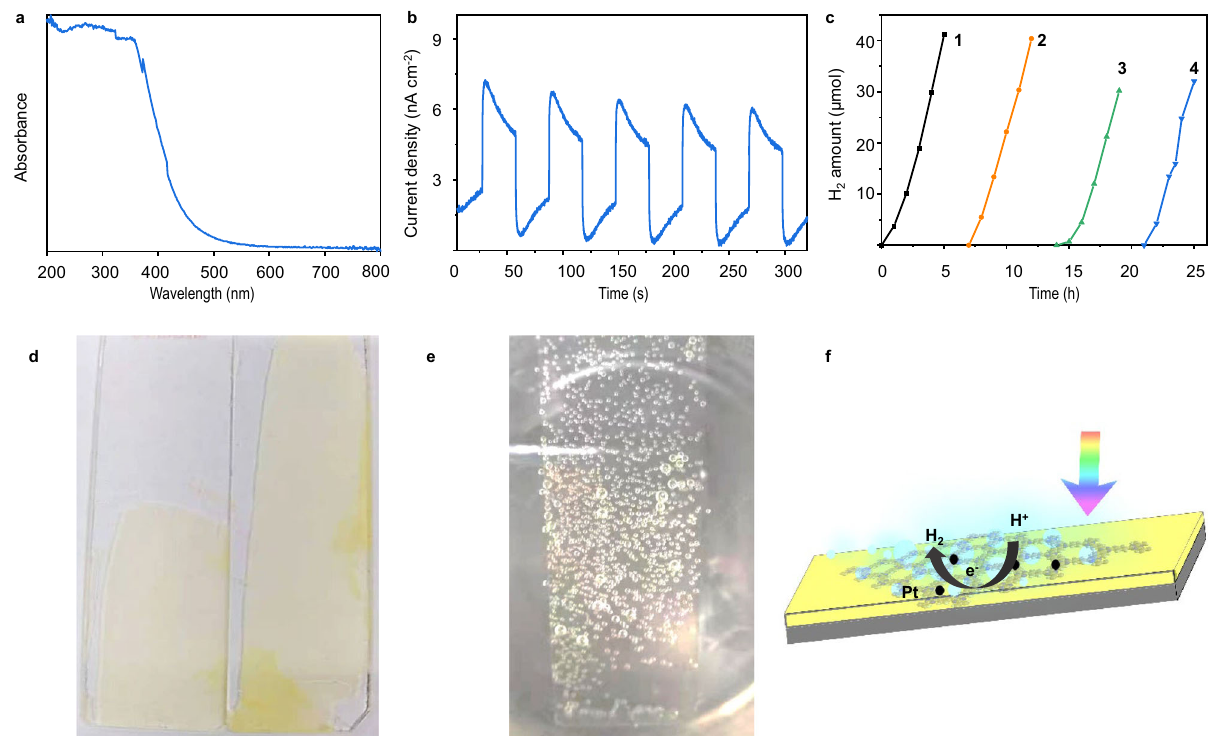
Fig. 6 Photoelectric and photocatalytic HER performance. a UV-visible light absorption spectrum of CTF fi lm. b The photocurrent curve. c Photocatalytic HER performance of fi lm on glass in four cycles under visible light (>420 nm). d Images of CTF fi lm loaded on glass. e Image of CTF fi lm loaded on glass for photocatalytic HER. f Schematic diagram of the photocatalytic